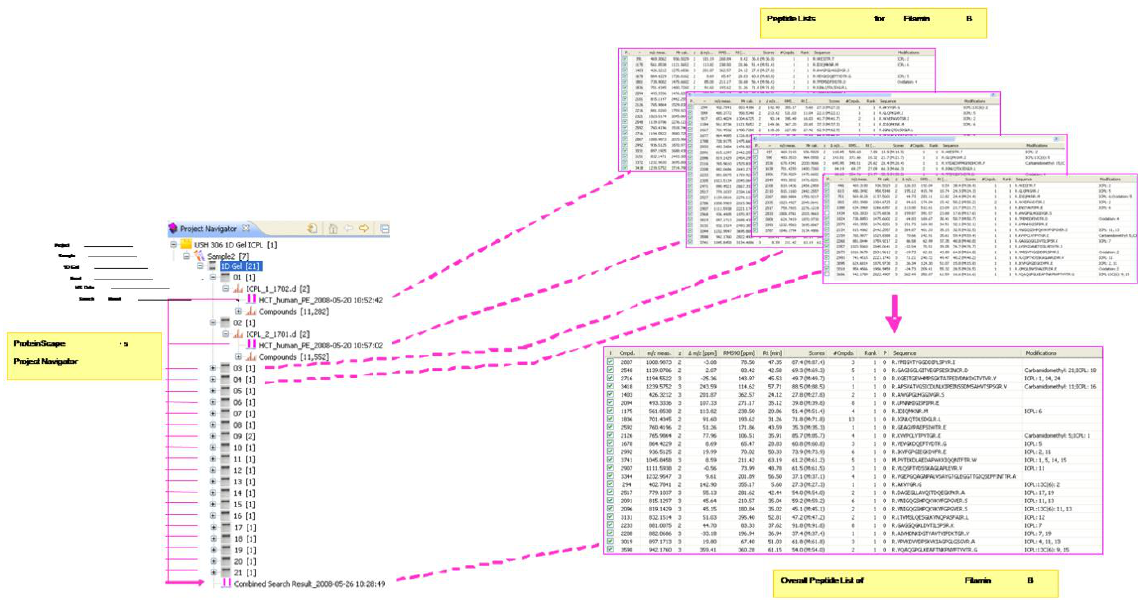
Fig. 3: Data handling in ProteinScape. The Project Navigator of ProteinScape (left) displays the 1D gel workflow incl. LC-MS/MS data and search results which have been compiled by the Protein Extractor(1) into one respective protein list for each band and (2) into one integrated protein list for the whole gel. On the right, the peptide lists for Filamin B for bands 1 to 4 and the overall peptide list are